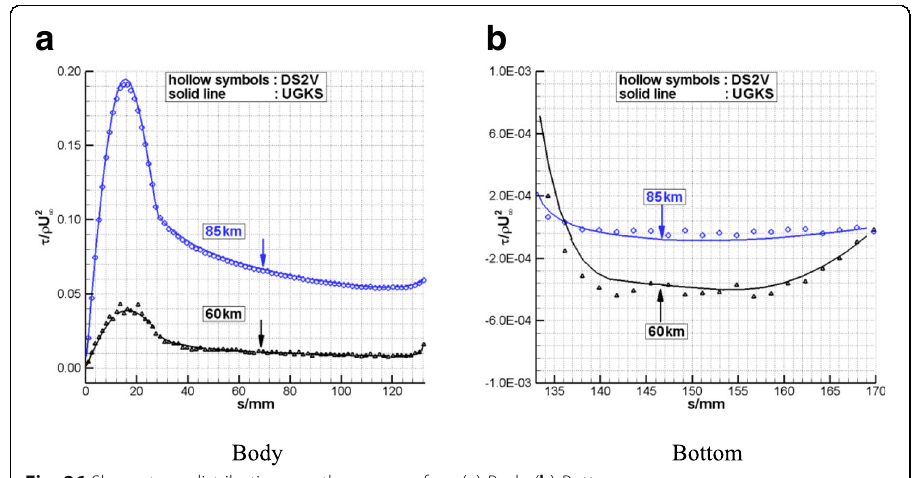
Fig. 26 Shear stress distributions on the cone surface ( a ) Body ( b )